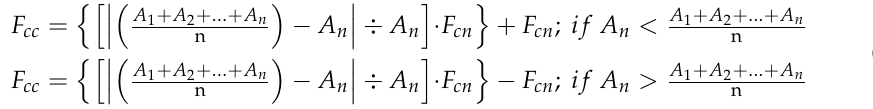
which were determined for the blade angle α = 30 ◦ , and the distances g = 0.1, 0.2, and